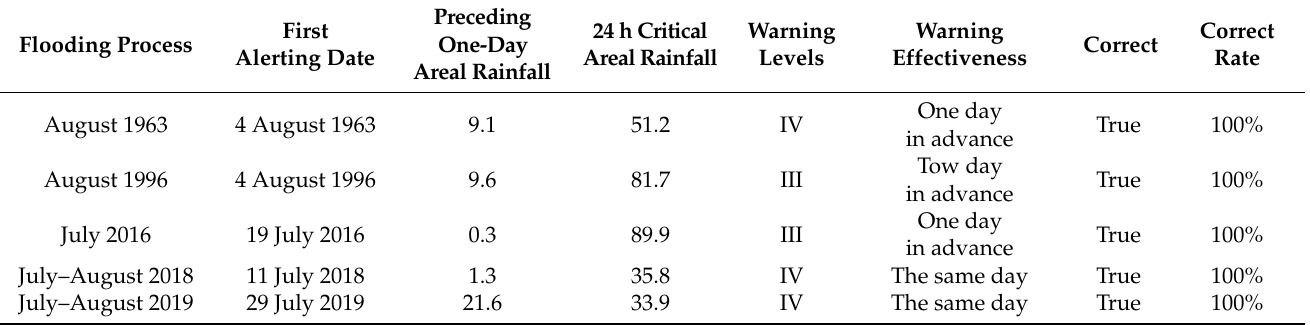
Table 4. Validation results of the historical flood event warnings in the Zhulong river